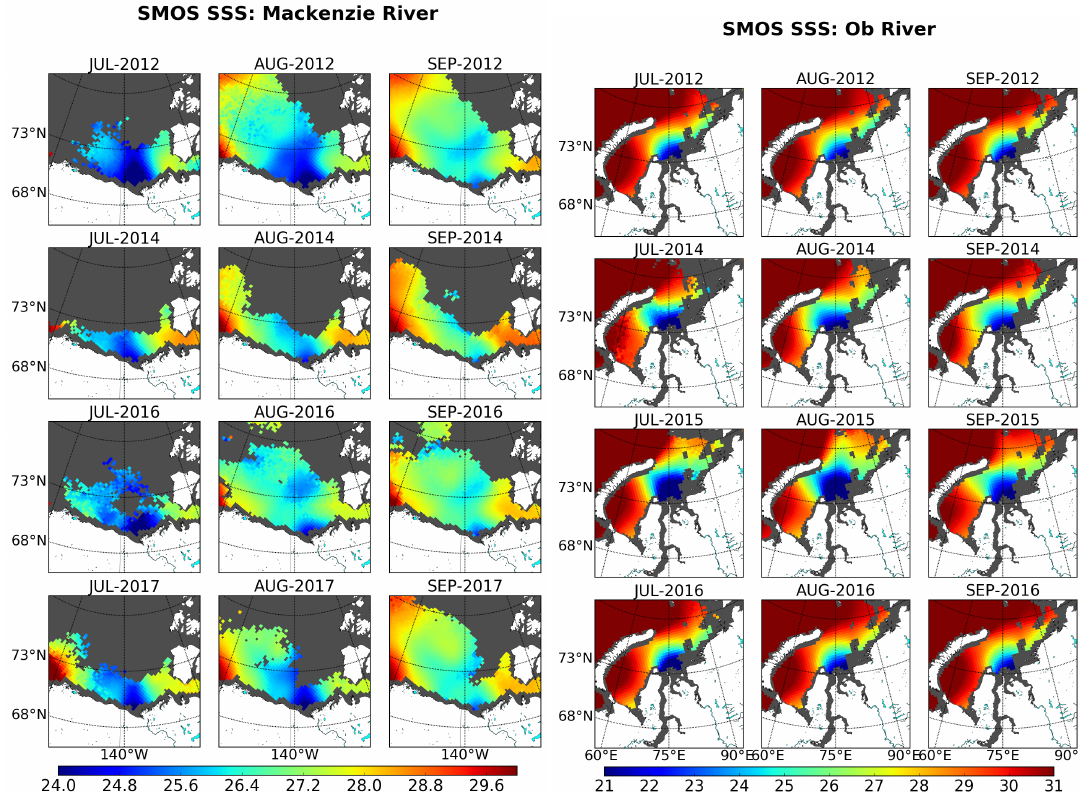
Figure 11. Monthly SMOS SSS maps close to the mouth of Mackenzie River: ( left ); and Ob River ( right